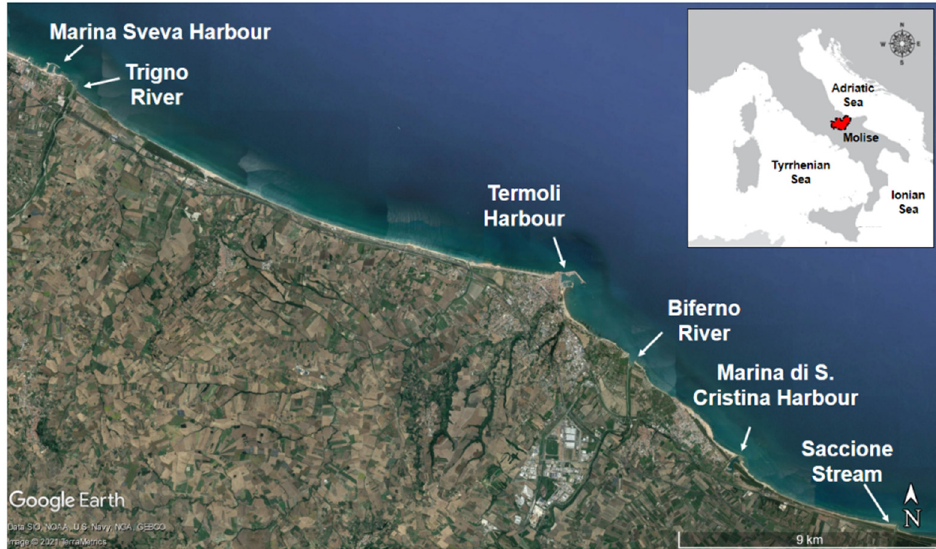
Figure 1. Detail of Molise coast.